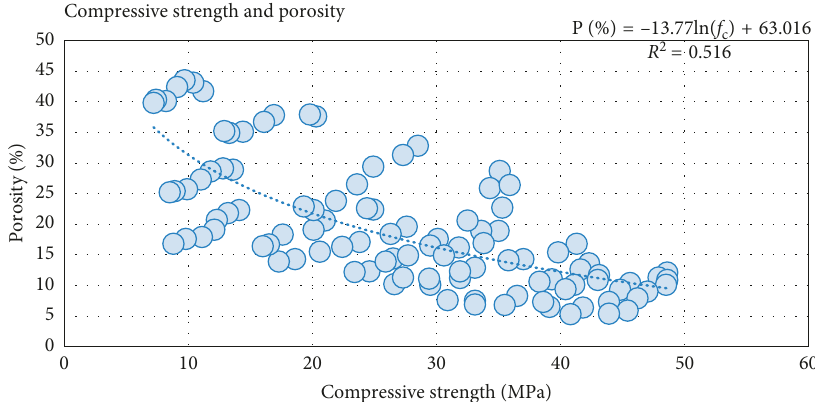
Figure 12: Correlation between water permeability and compressive strength of VS-based